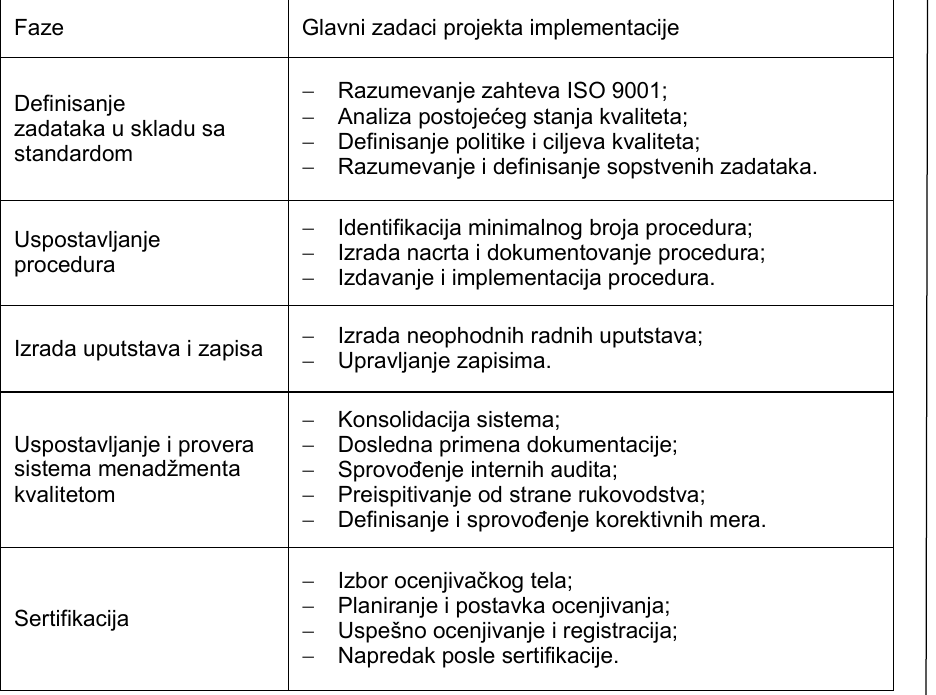
Table 2 – Phases in the introduction of a quality management